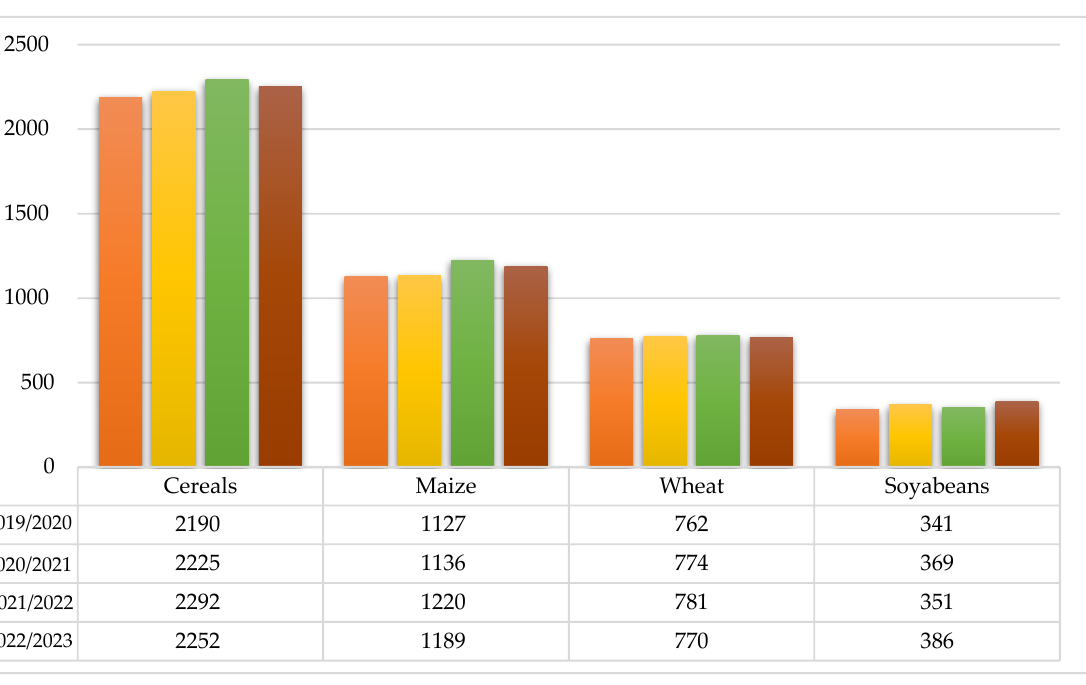
Figure 1. Trend of the agriculture output (million tonnes) Source: realised by authors after [3].